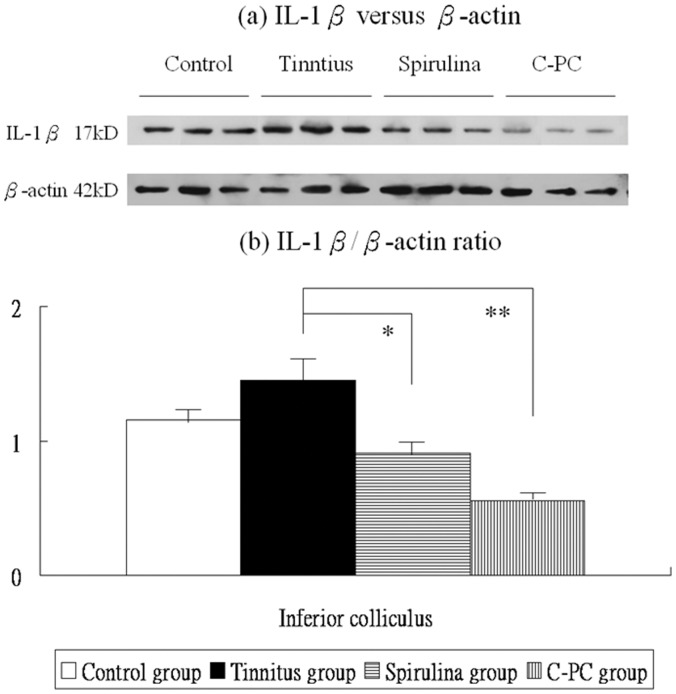
The levels of IL-1β protein expression in the IC (a,b).There are significant differences in these levels among four groups. The IL-1β protein expression were not significantly higher in the salicylate group than the control group. Compared to the tinnitus group, the Spirulina group (*) or C-PC group (**) exhibits significantly reduced TNF-α protein levels in the IC.